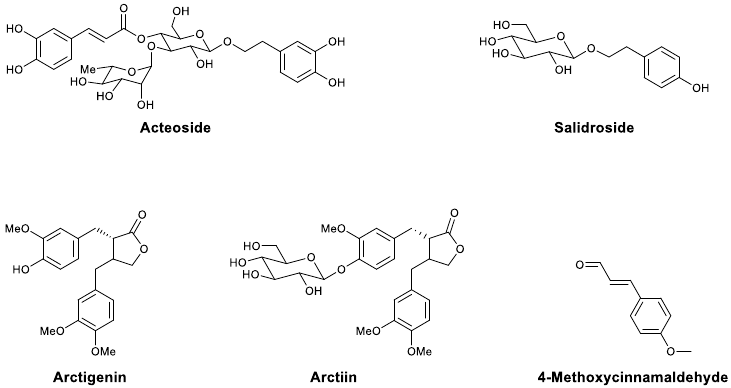
Figure 5. Structures of acteoside, salidroside, arctigenin, arctiin, and